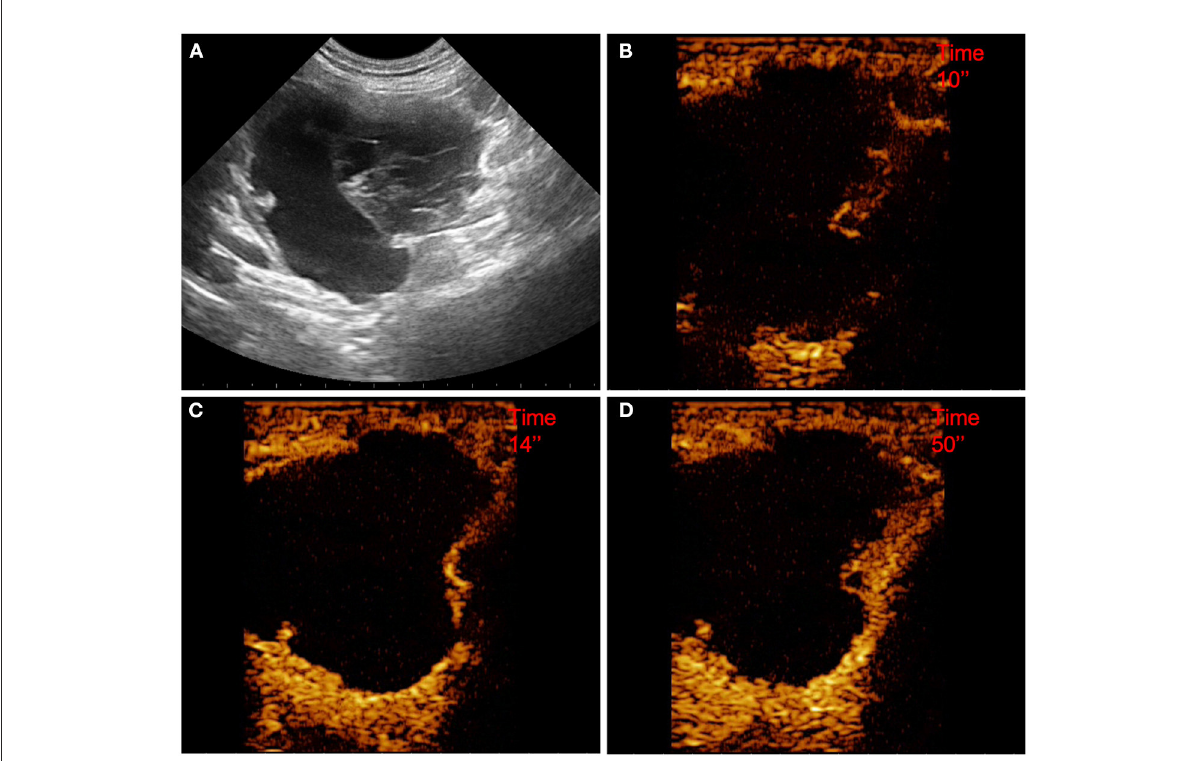
FIGURE5 Example of a pseudocyst (OBL) showing: pseudocystic appearance, mixed echogenicity, presence of acoustic enhancement, and presence of peripancreatic reactivity at US; hyperenhancement, peripheral and homogeneous distribution of contrast medium, absence of intralesional microcirculation, and presence of hypoperfused areas during wash-in at CEUS; no wash-out. (A) Image obtained from US examination; (B) image obtained at TTE; (C) image obtained at TTP; (D) image obtained during